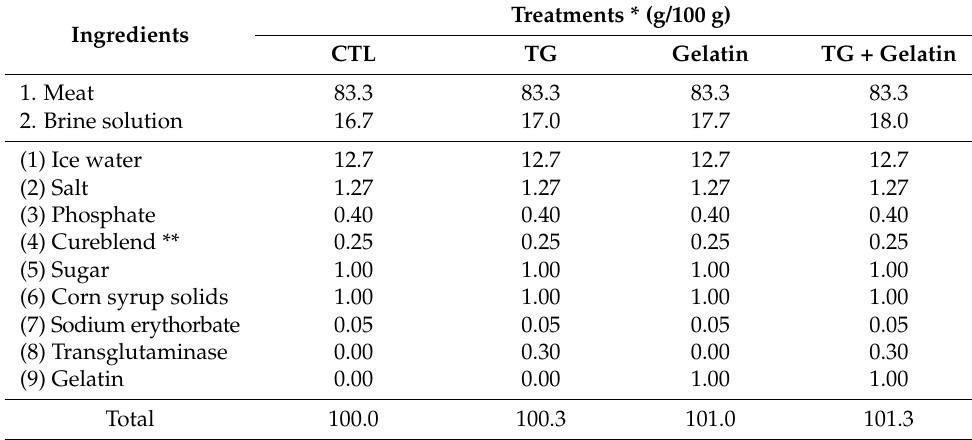
Table 4. The formulation of the manufacture of restructured pork ham with pork skin gelatin and